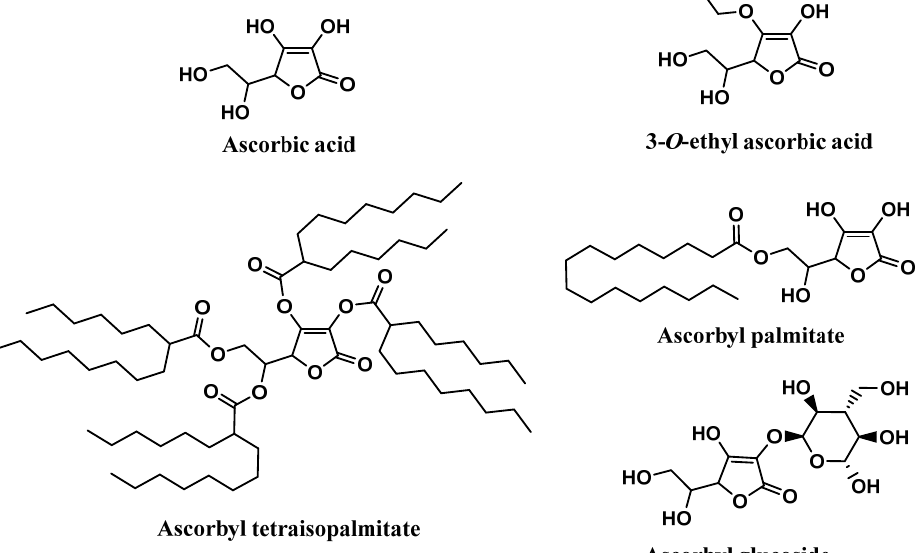
Figure 8. Chemical structure of vitamin C and its